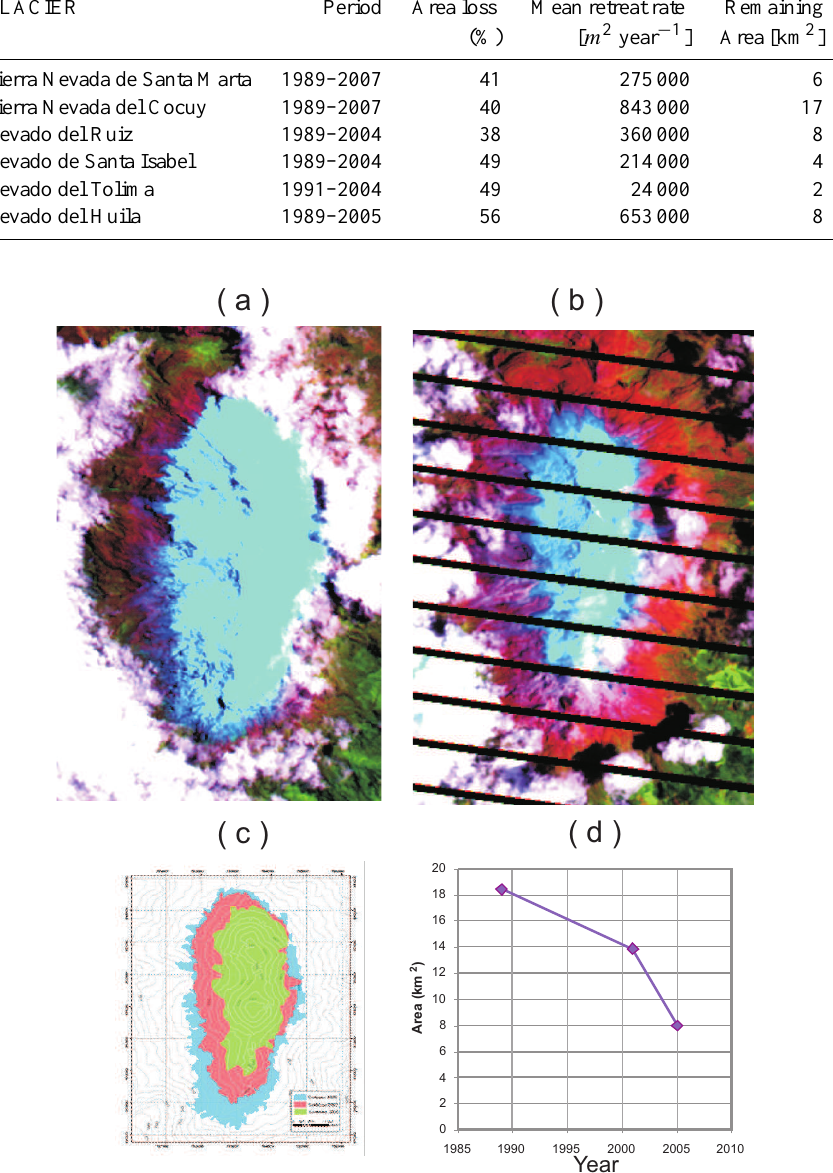
Fig. 7. Landsat images of Nevado del Huila in (a) August 1989, and (b) December 2005. (c) Glacier countours in 1989 (blue), 2001 (pink), and 2005 (green). (d) Time evolution of glacier areal extent: 18.39 km 2 (1989), 13.84 km 2 (2001), and 7.94 km 2 (2005).